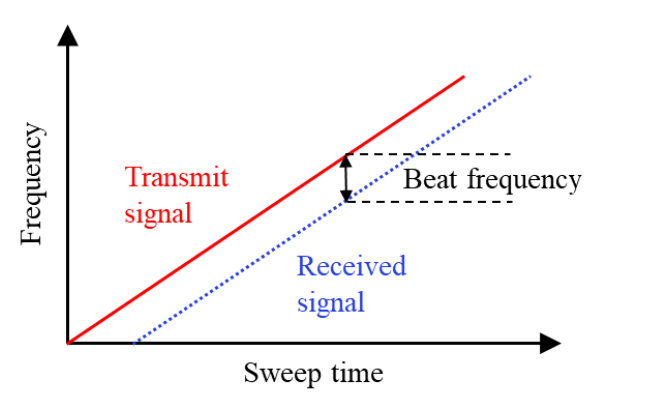
Figure 2. Illustration of the frequency modulated continuous wave (FMCW) radar principle [6]. Using a frequency sweep allows to compute the distance from the radar to the